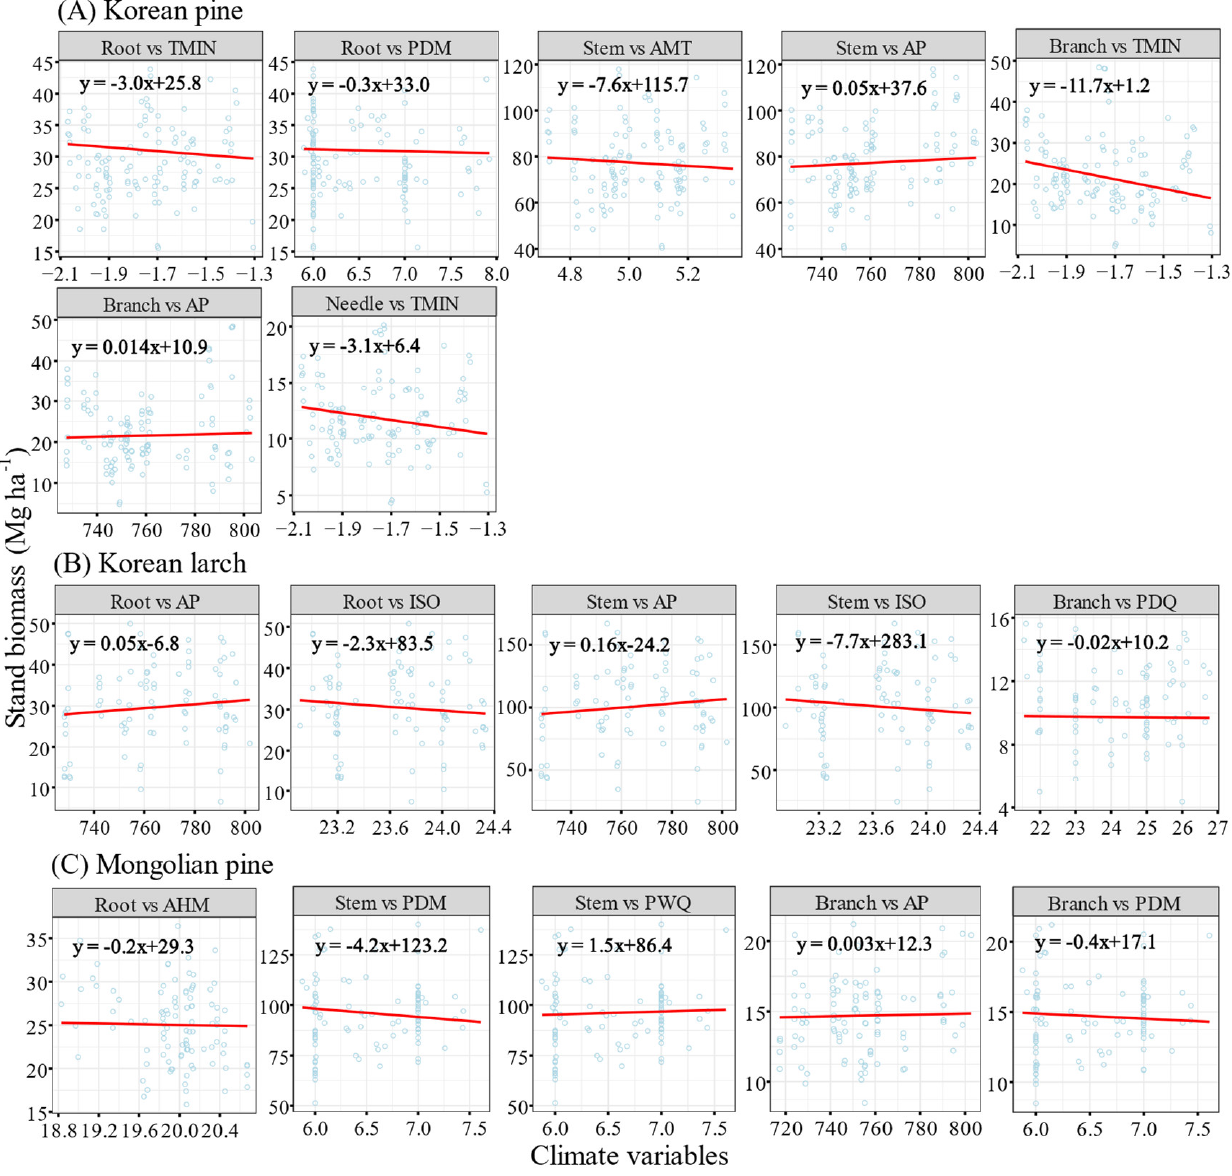
Figure 7. Plots of stand component biomass to climate variables for ( A ) Korean pine, ( B ) Korean larch, and ( C ) Mongolian pine. The red line in each plot is the estimate of the smooth function (linear model) that simulate the effects of climate change on stand component biomass.